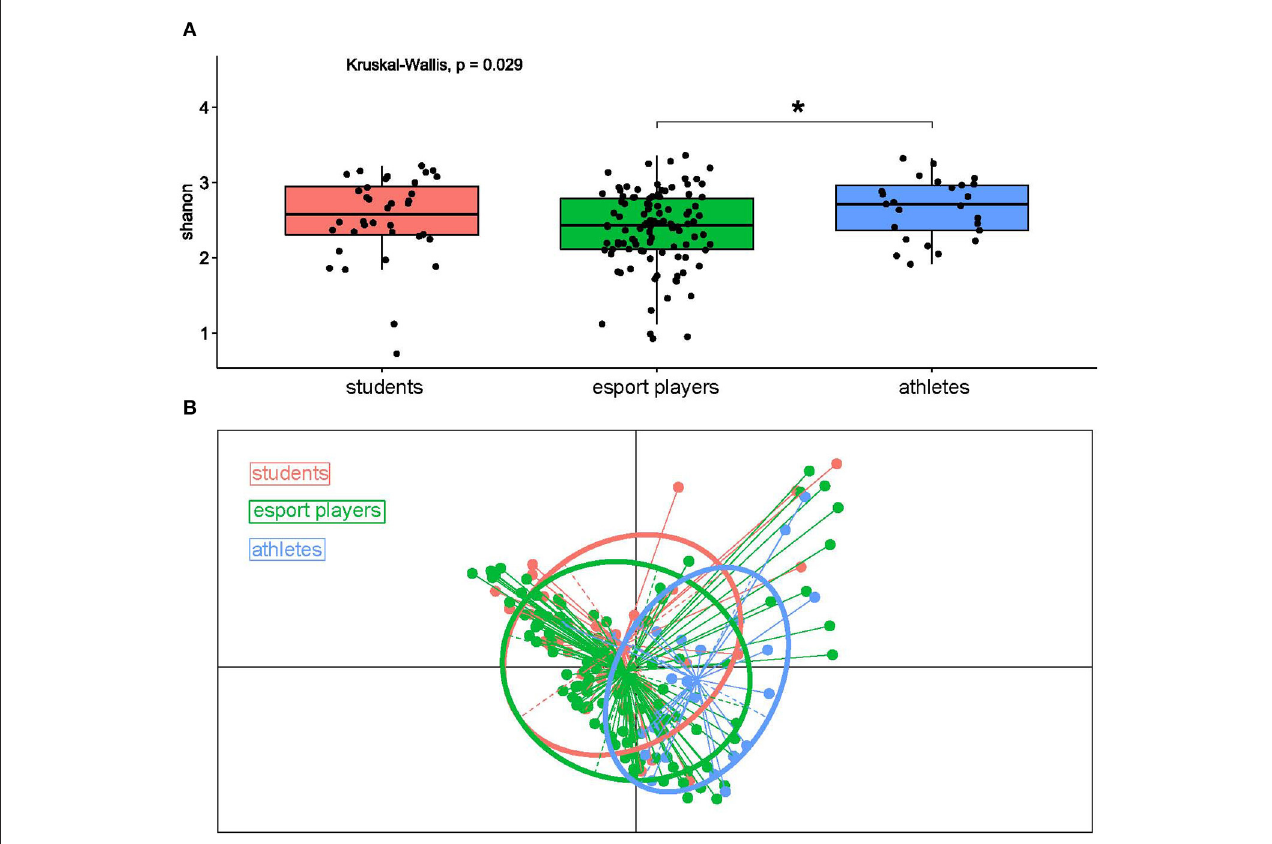
FIGURE3 (A) α -diversity, as measured by the Shannon index, in students, esports players, and professional athletes. (B) PCoA, based on Bray Curtis distances, of students, esports players, and professional athletes. *: p ≤ 0.05.